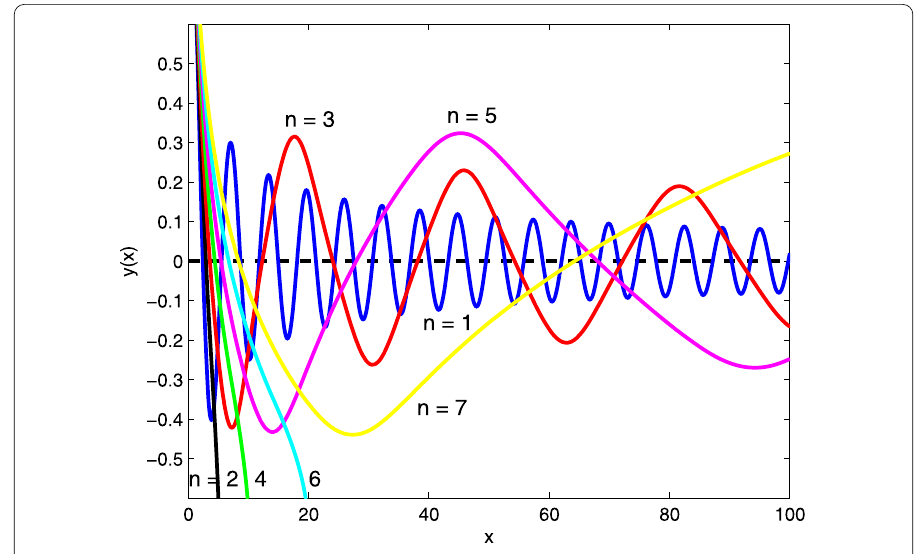
Figure 1 The numerical solutions of the cylindrical equation (8) with D = 2, integer n = 1 – 7, and boundary conditions y (0) = 1 and y (cid:2) (0) = 0. The solutions with odd n are oscillatory about y = 0, while the solutions with even n are